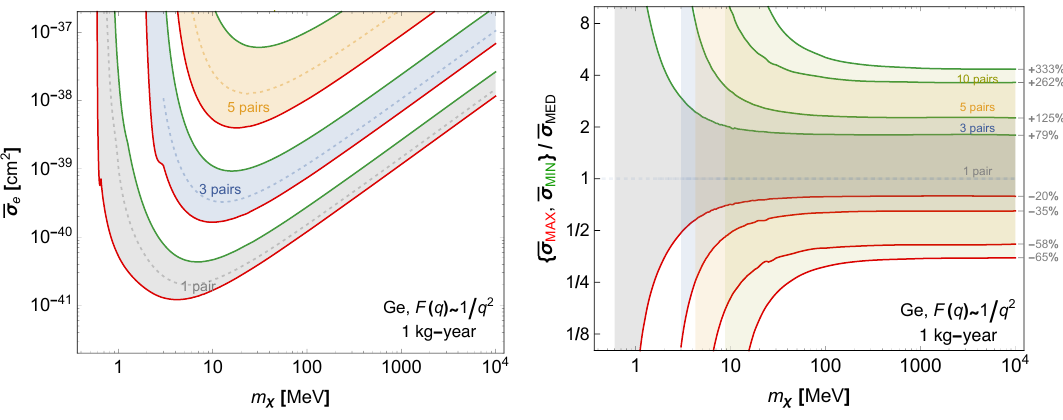
1 =q 2 form factor. /